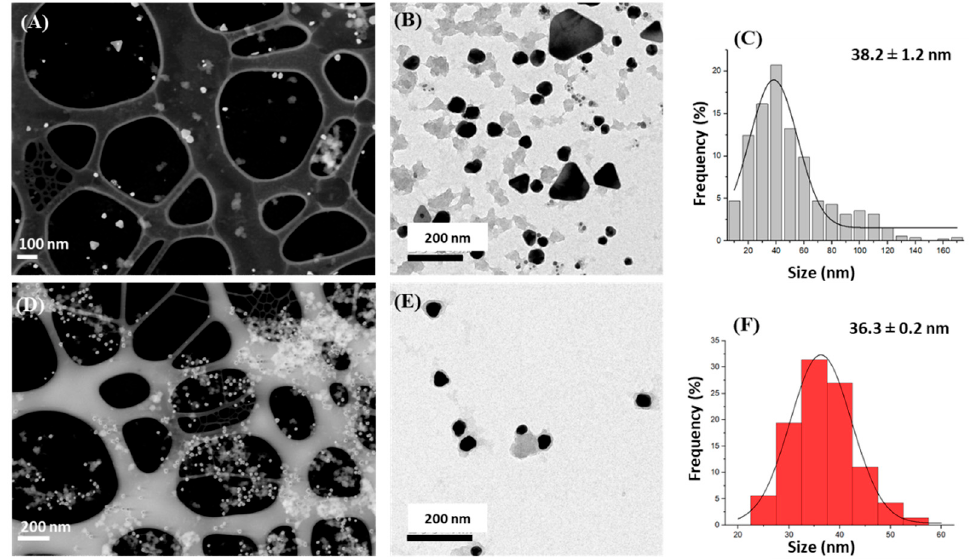
Figure 2. Scanning and Transmission electron microscopy (STEM) micrographs of the ( A ) green silver nanoparticles (G-AgNPs) and ( D ) green gold nanoparticles (G-AuNPs), Transmission electron microscopy of ( B ) G-AgNPs and ( E ) G-AuNPs, and their corresponding size histograms for ( C ) G- AgNPs and ( F ) G-AuNPs.